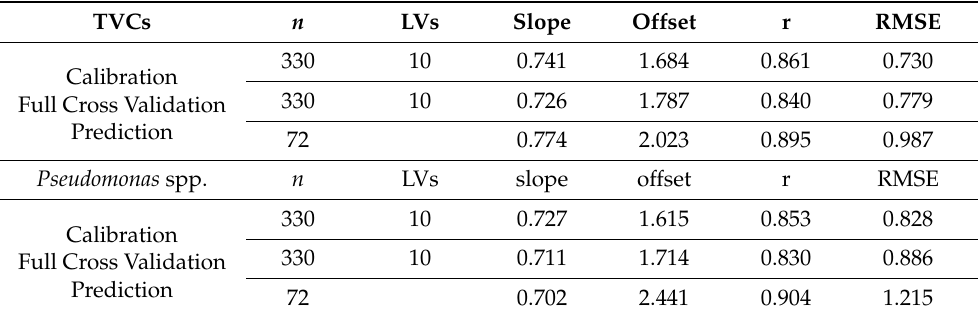
Table 2. Performance metrics of the developed PLS-R models estimating TVCs and Pseudomonas spp. counts of chicken thigh samples via MSI spectral data